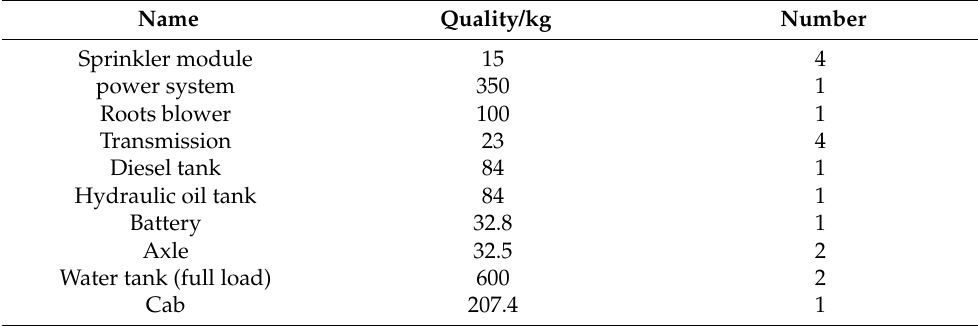
Table 2. Quality parameters of